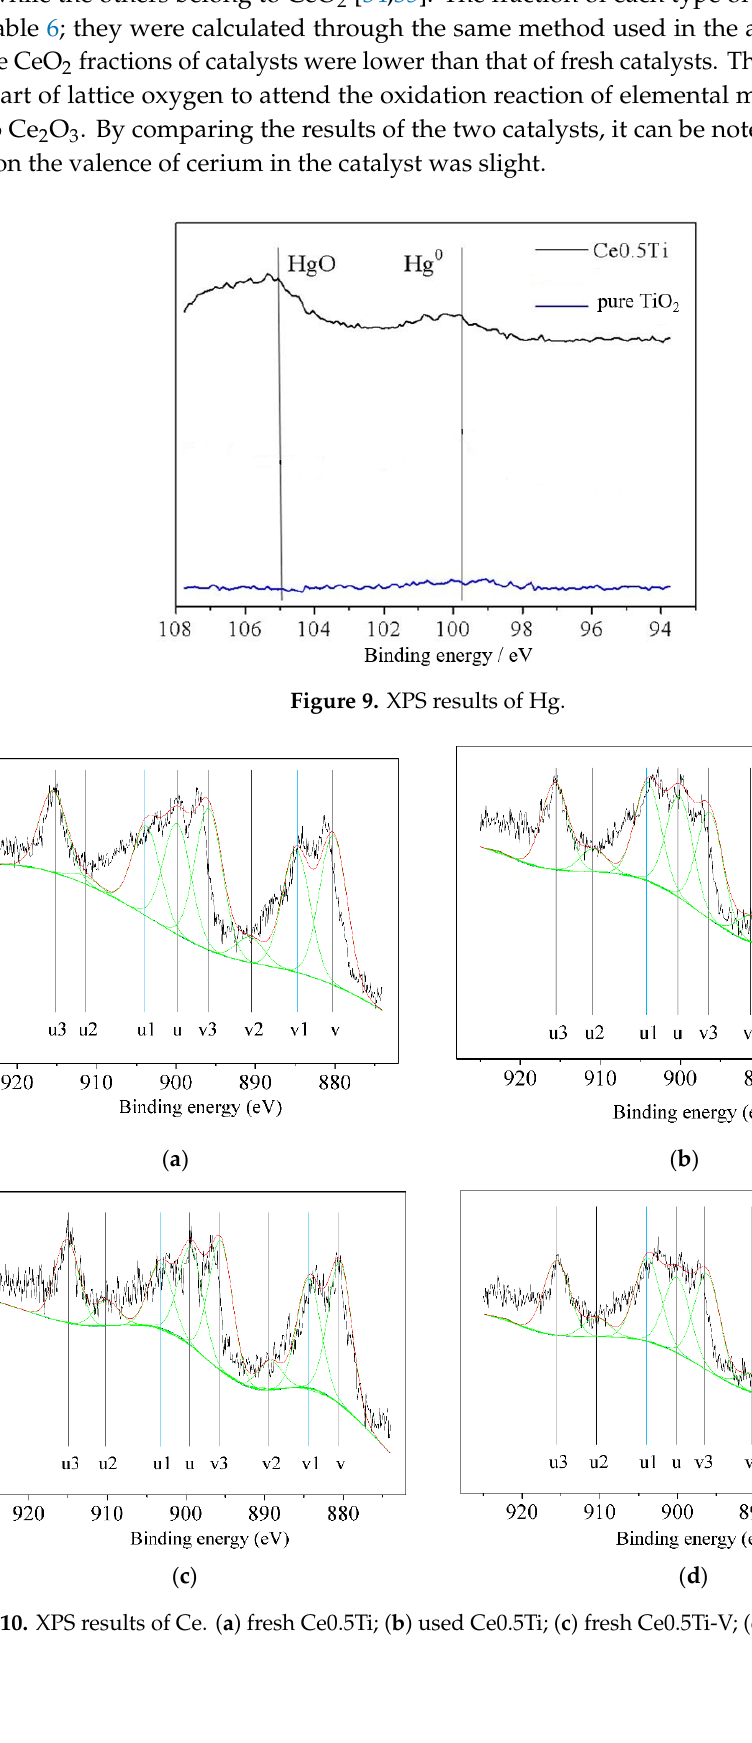
Figure 10. XPS results of Ce. ( a ) fresh Ce0.5Ti; ( b ) used Ce0.5Ti; ( c ) fresh Ce0.5Ti-V; ( d ) used Ce0.5Ti- V. Table 6. The fraction of each type of cerium.